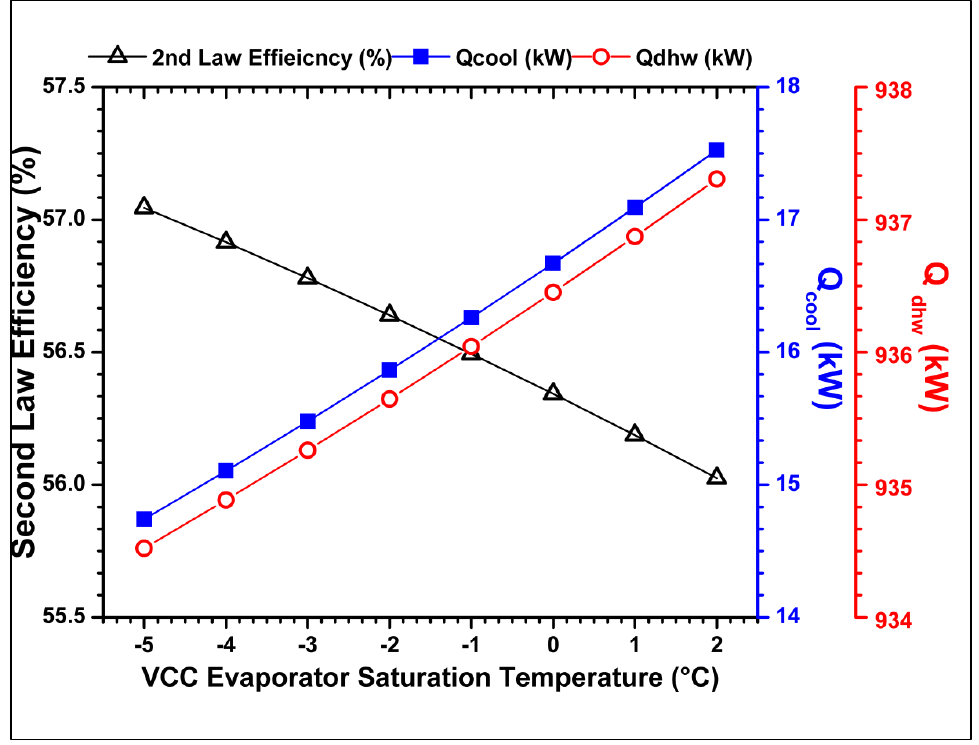
Figure 12. The variation of the cooling, heating, and second law efficiency against the saturation evaporation temperature of the VCC.